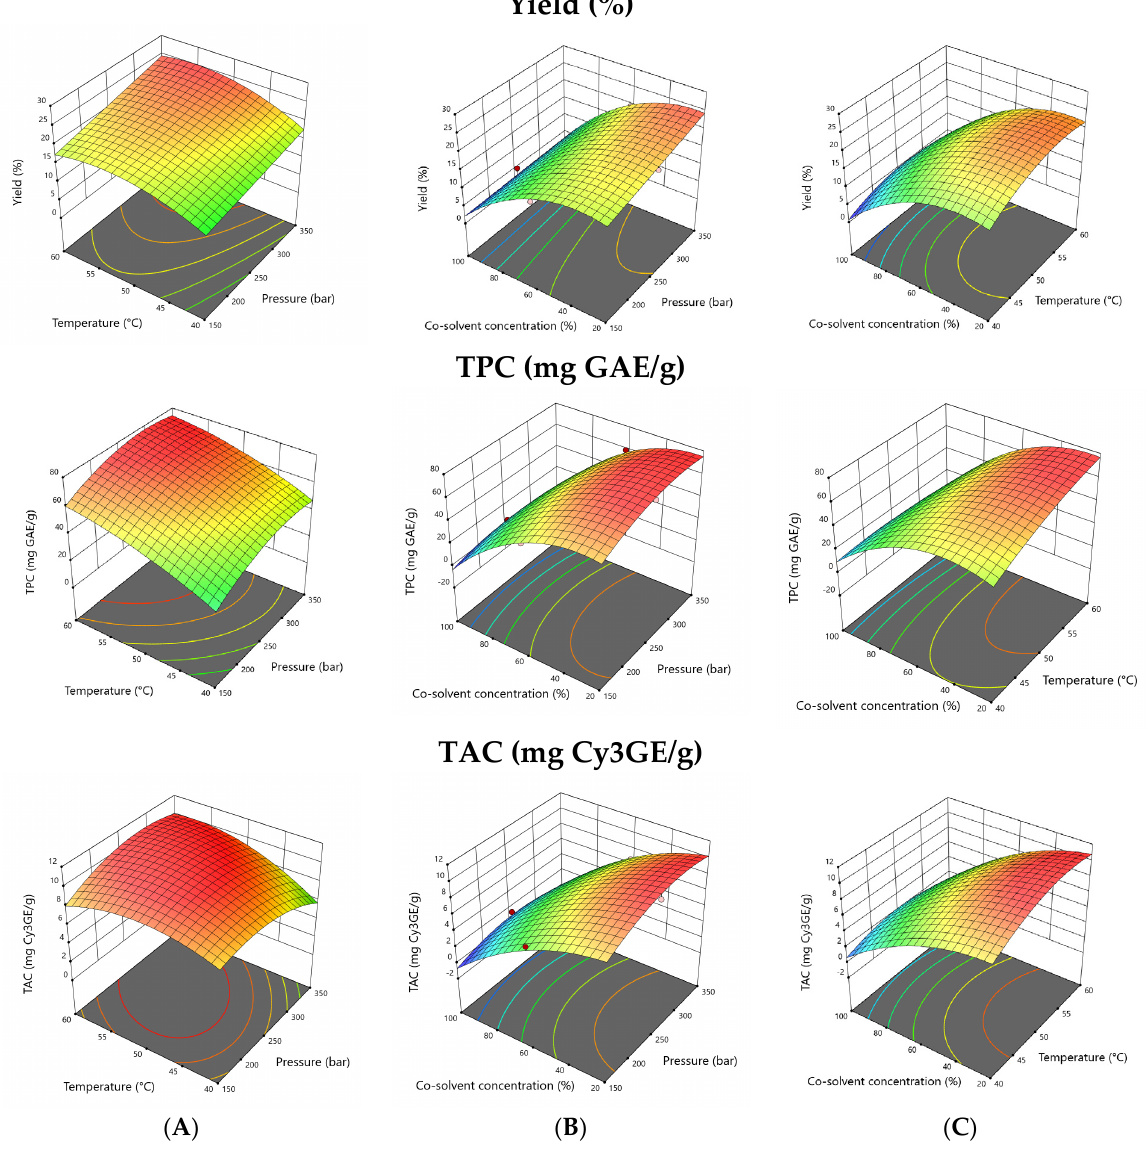
Figure 1. Response surface plots for the interactive effects of ( A ) pressure and temperature; ( B ) ex- traction pressure and co-solvent concentration; ( C ) temperature and co-solvent concentration on the extraction yield, total phenolics content (TPC) and total anthocyanin content (TAC) recovered from black rosehip. The excluded variable was fixed at its optimal point.